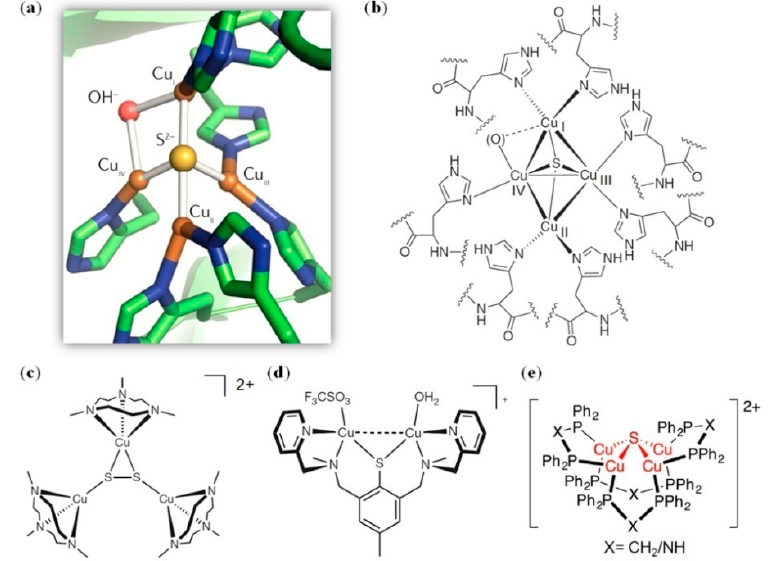
Figure 8. ( a ) The X-ray structure of the Cuz center in N 2 OR from P. nautica (PDB code 1QNI [112]); ( b ) The coordination geometry of the Cuz center in native N 2 OR; ( c – e ) The structures of the synthetic functional models of the native Cuz center [117–119].